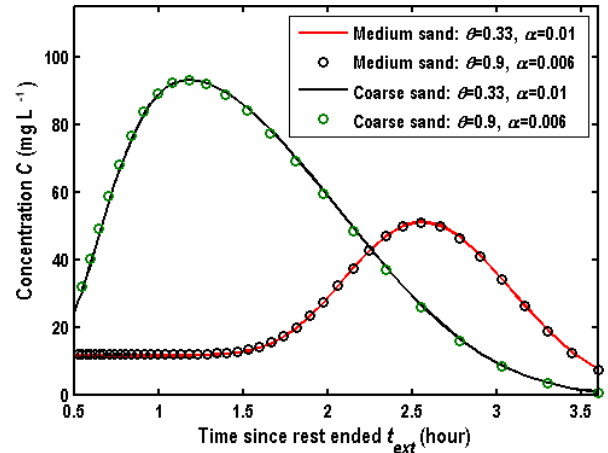
Figure 8. Comparison of BTCs for different dispersivities and porosities but for the same hydraulic